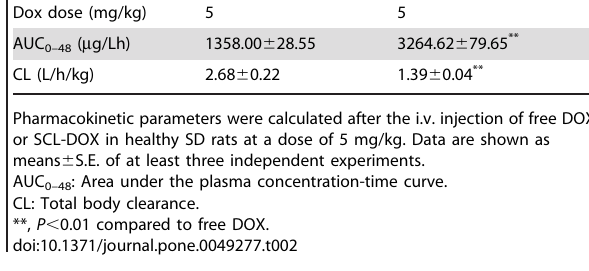
Figure 2. Intracellular retention of SCL-DOX in HT-29 cells. HT-29 cells were first incubated with 2 m g/mL free DOX or equivalent SCL-DOX for 24 h. After two washes with PBS to remove the drugs, cells were cultured in fresh full culture medium followed by imaging serially at 1 h, 2 h, 4 h and 24 h using fluorescence confocal microscopy. ( A ) Cells treated with free DOX. ( B ) Cells treated with SLC-DOX. Red: fluorescence from DOX; blue: nuclei stained with Hoechst 33342. Scale bars: 10 m m.